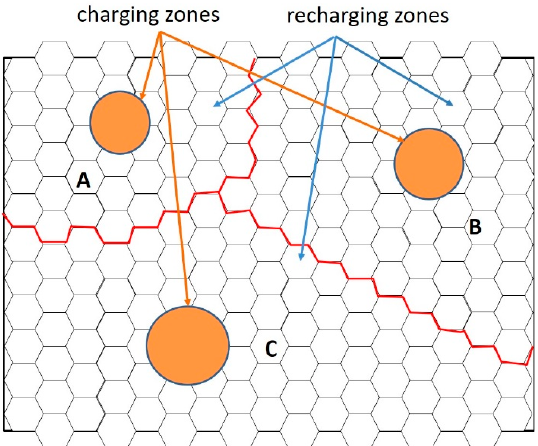
Figure 1. The environment is divided into zone A, zone B, and zone C according to the amount of independent energy supply zones.